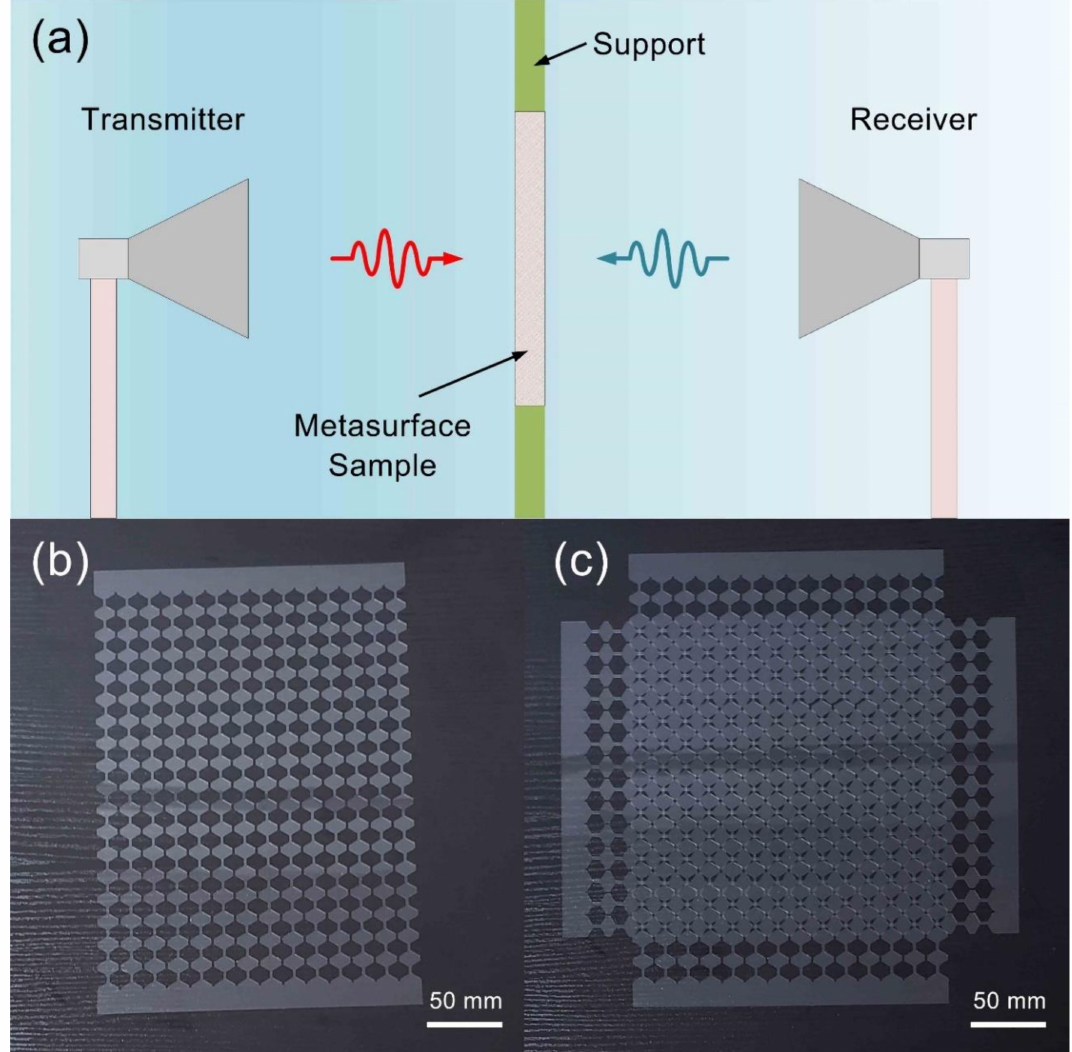
Figure 6. The experiment configuration of the presented metasurface and the fabricated metasurface sample. ( a ) The measurement performed within a wide-band horn antenna platform to test the S-parameters. ( b ) The fabricated metasurface sample of the single layer. ( c ) The assembled dual-layer metasurface